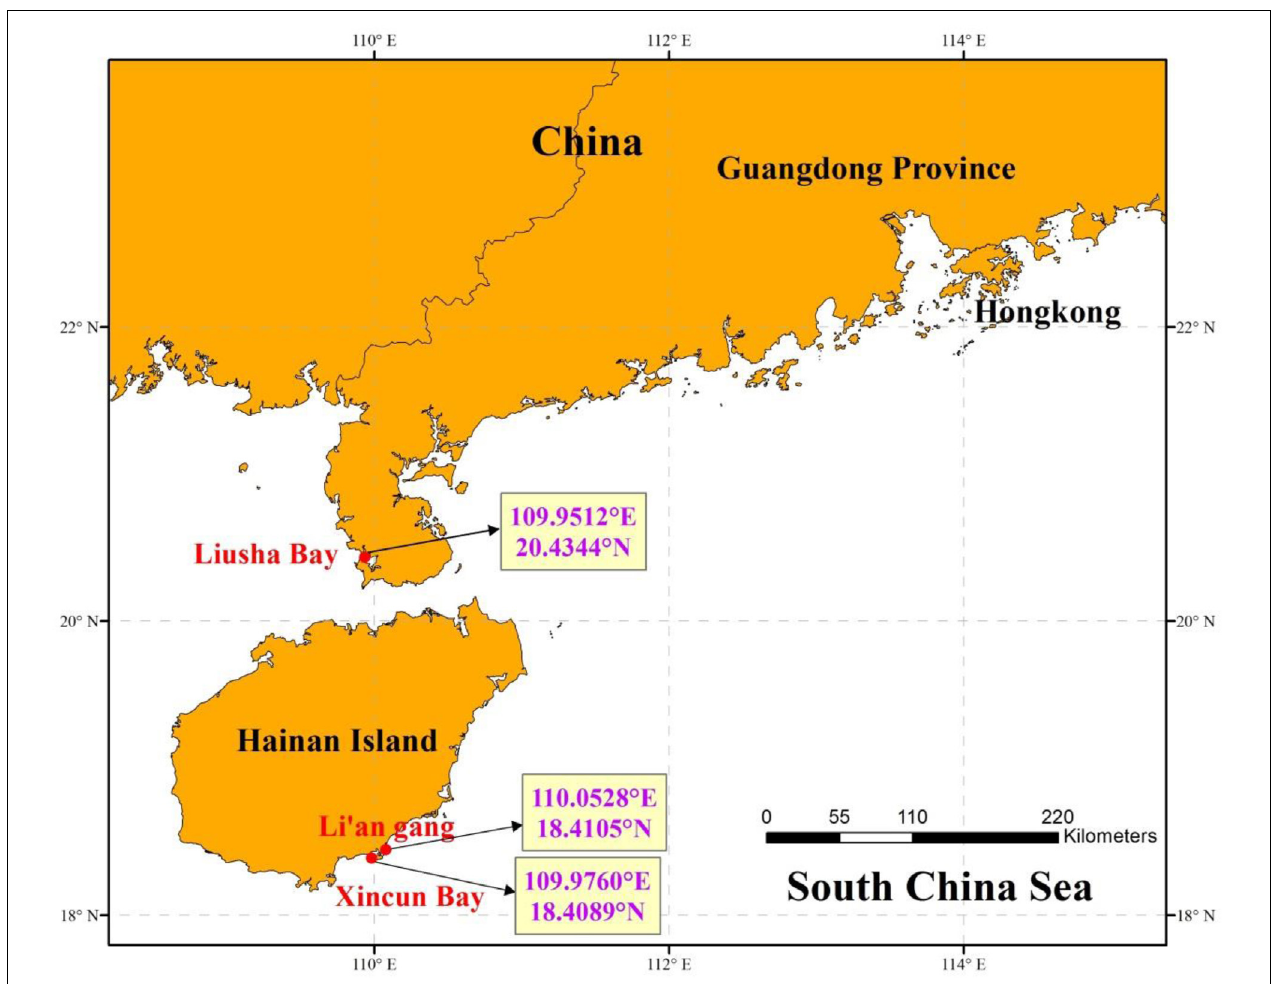
FIGURE 1 | The sampling locations in seagrass beds at Liusha Bay (Guangdong Province), Li’an gang, and Xincun Bay (Hainan Island).